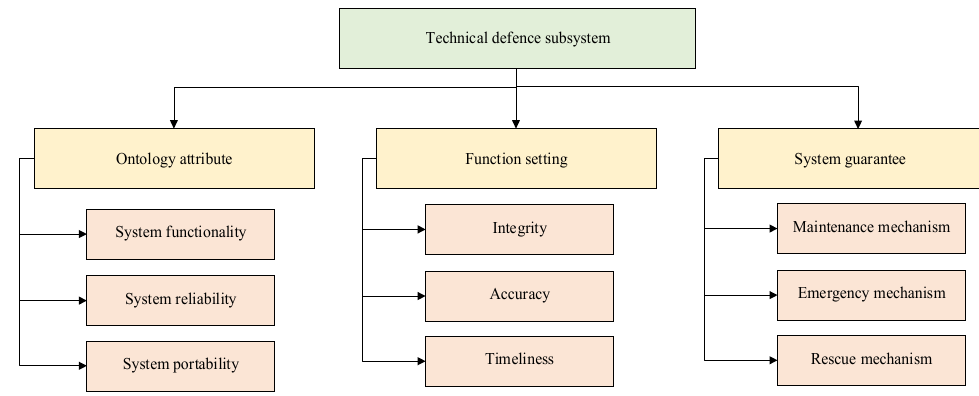
Figure 9. Measurement framework of the technical defence system capability indicator.